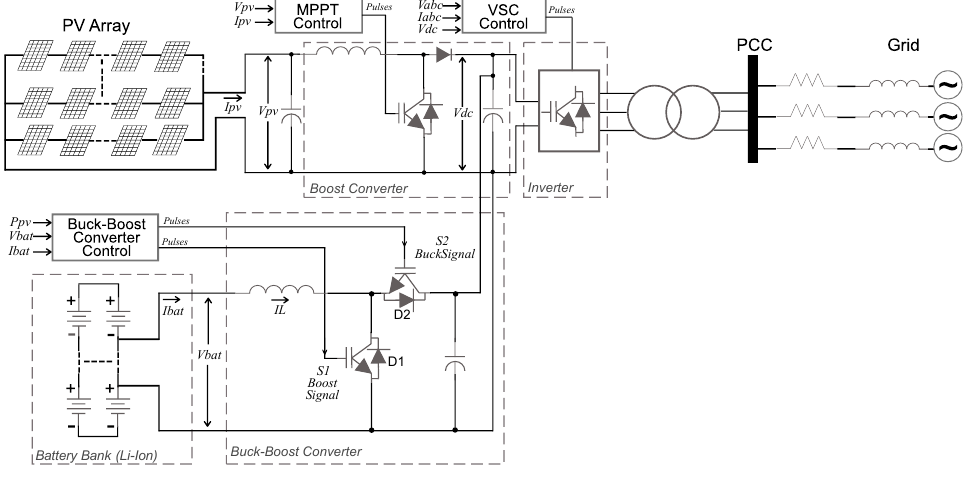
Figure 5 and was carried out by integrating three components: battery bank, bidirectional DC/DC buck–boost converter, and control unit.